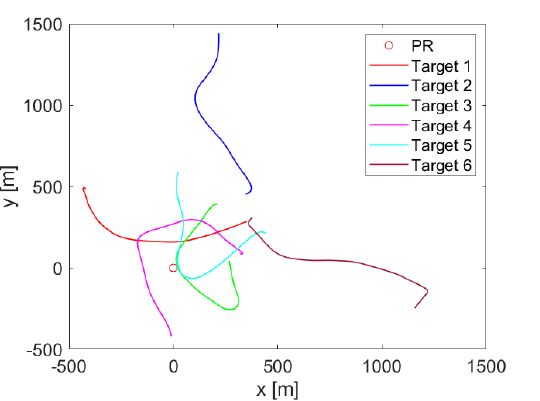
Figure 7. PR receiver location and targets’ trajectories in the simulated